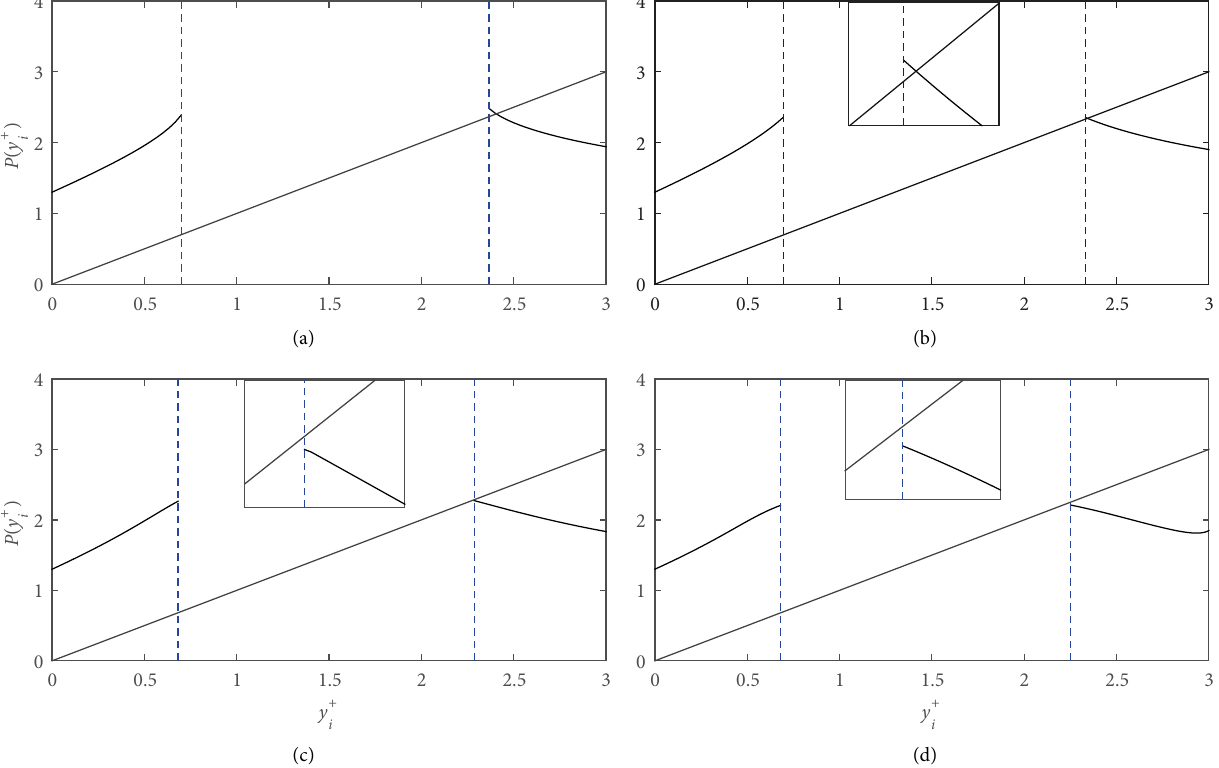
Figure 8: Effect of weighted parameters on the fixed point of Poincaré map for Case All other parametric values are fixed as: